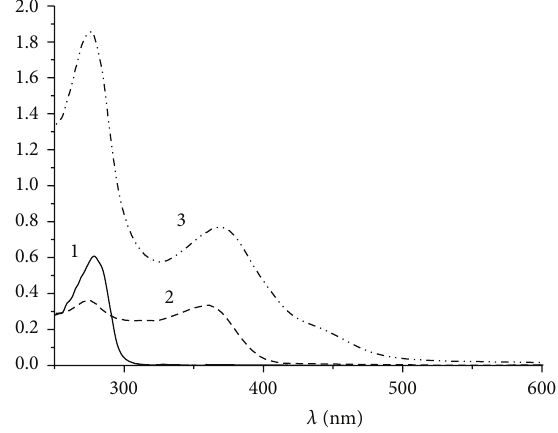
Figure 2: Absorbance spectra of BSA ( 1 ), TC ( 2 ), and the TC-BSA conjugate ( 3